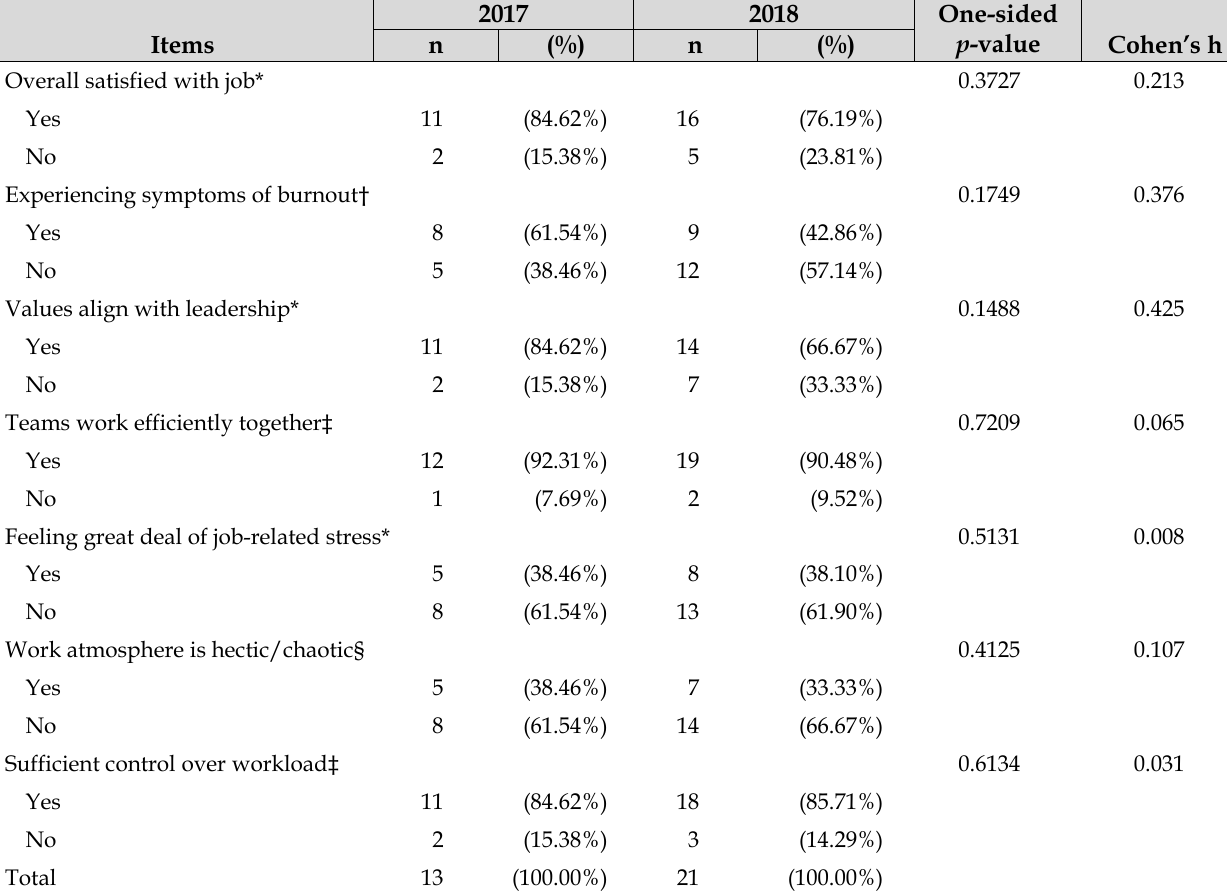
Table 3 Comparison of AMA Mini-Z items for library staff between 2017 and